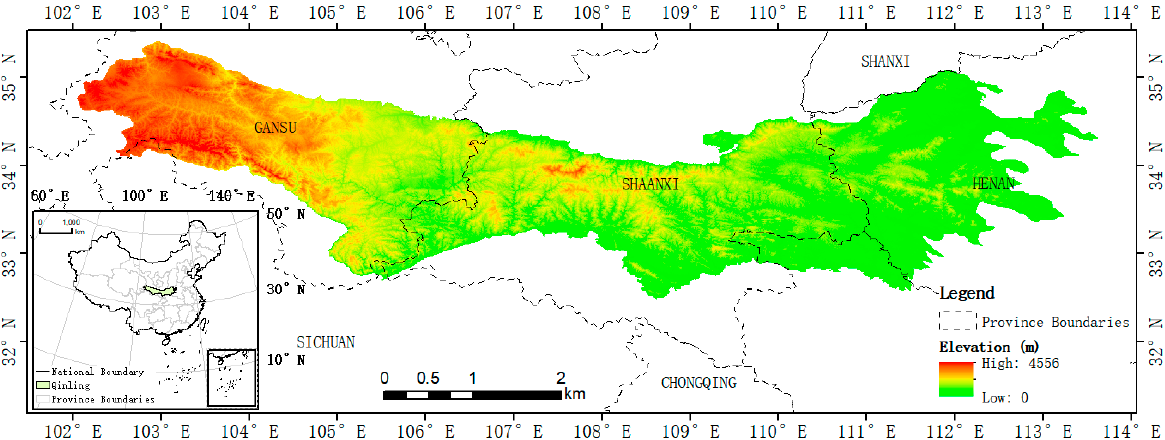
Figure 1. Geographic location of Qinling Mountains.